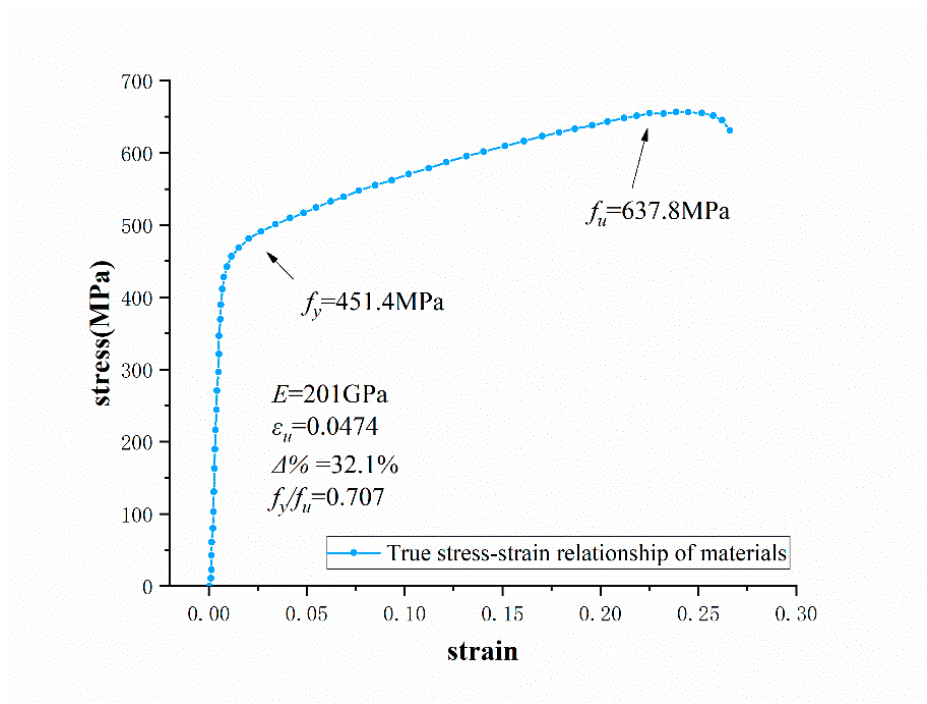
Figure 8. True stress – strain curve based on standard tensile test.